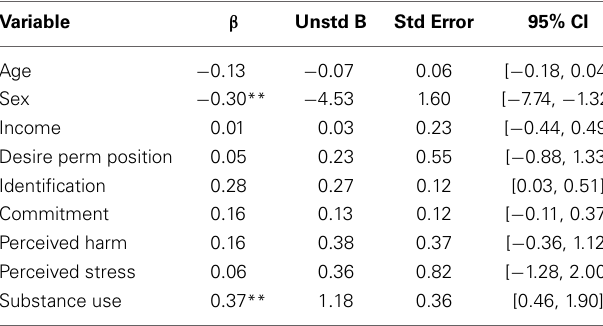
Table 10 | Standard multiple regression predicting